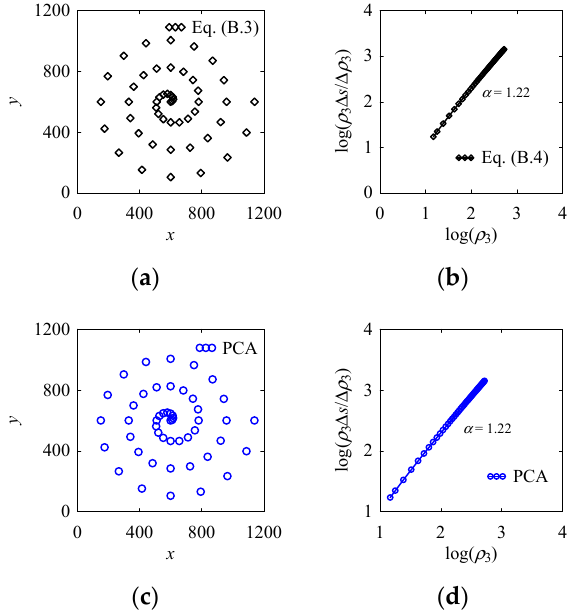
Figure 15. Logarithm curvature histogram of spirals. ( a ) Point of a spiral modeled by a parametric-based equation; ( b ) LCH of ( a ); ( c ) point cloud of a spiral modeled by the PCA; ( d ) LCH of ( c ).